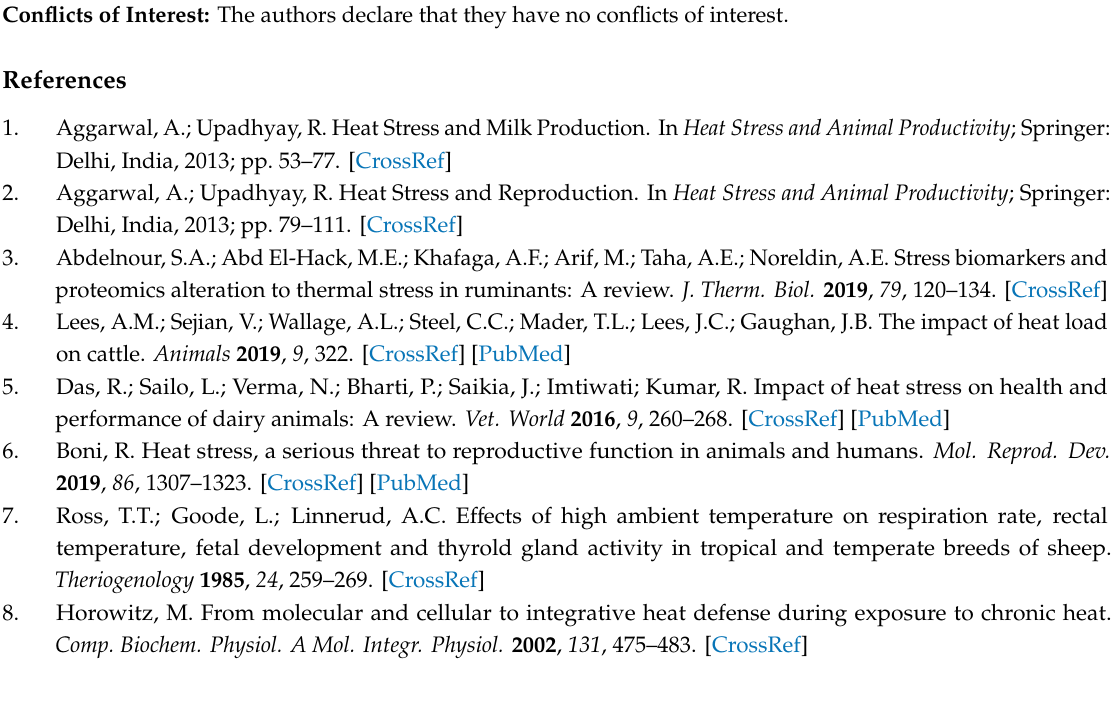
Figure S1: Experimental design flowchart; Figure S2: High magnification of cow and sheep primary cultured fibroblasts after exposure to acute heat shock (4 ◦ C for 4 h); Figure S3: High magnification of the recovered cow and sheep primary fibroblasts when re-exposed to acute heat shock (4 ◦ C for 4 h); Figure S4: High magnification of the first passage cow and sheep fibroblasts exposed to acute heat shock (4 ◦ C for 4 h); Table S1: Primers used for relative quantitative PCR; Table S2: Correlation coe ffi cient between fold changes of di ff erent mRNA transcripts in primary cultured and first passage fibroblasts in cows; Table S3: Correlation coe ffi cient between fold changes of di ff erent mRNA transcript in primary cultured and first passage fibroblasts in